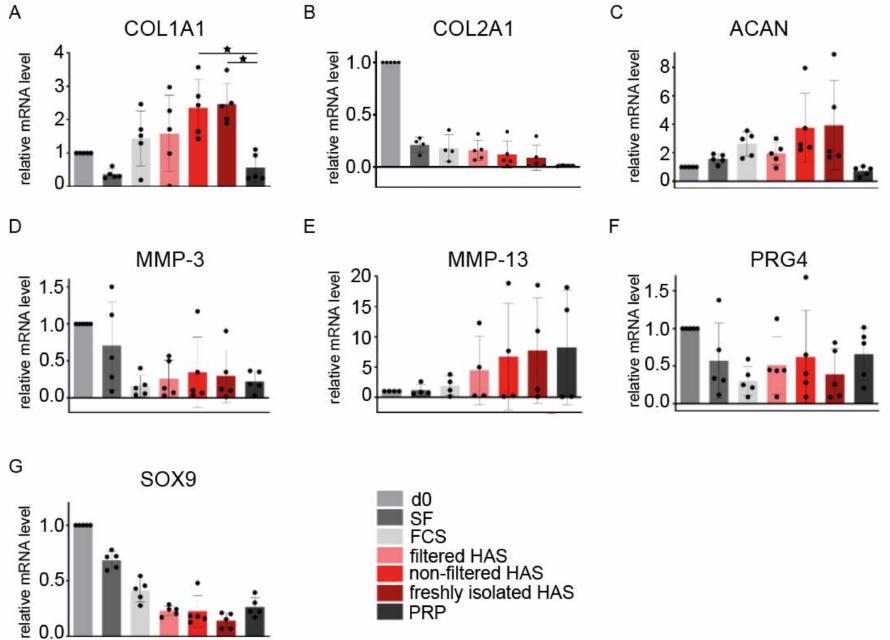
Figure 2. Gene expression of OA-related genes from a chondrogenic 2D culture after supplementation with different versions of HAS and PRP (n = 5). Tested genes include ( A ) Col1a1 , ( B ) Col2a1 , ( C ) Acan , ( D ) Mmp-3 , ( E ) Mmp-13 , ( F ) Prg4 , and ( G ) Sox9 . Bars represent arithmetic means and error bars, SD. Abbreviations: day 0 (d0), serum free (SF), fetal calf serum (FCS), hyperacute serum (HAS), platelet-rich plasma (PRP), collagen type I alpha 1 chain (COL1A1), collagen type II alpha 1 chain (COL2A1), aggrecan (ACAN), metalloproteinases (MMP), proteoglycan 4/lubricin (PRG4) and SRY-box transcription factor 9 (SOX9). Level of significance where p < 0.05